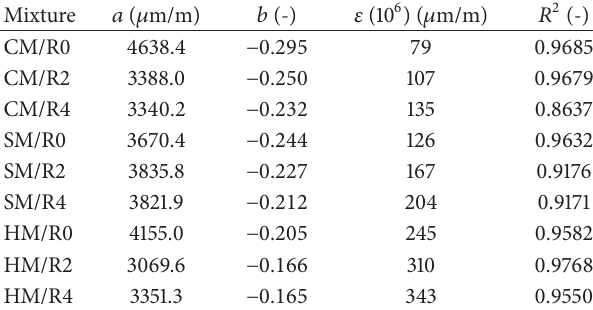
Table 6: Regression coefficients of the fatigue curves: 𝑁 𝑓 approach for aged